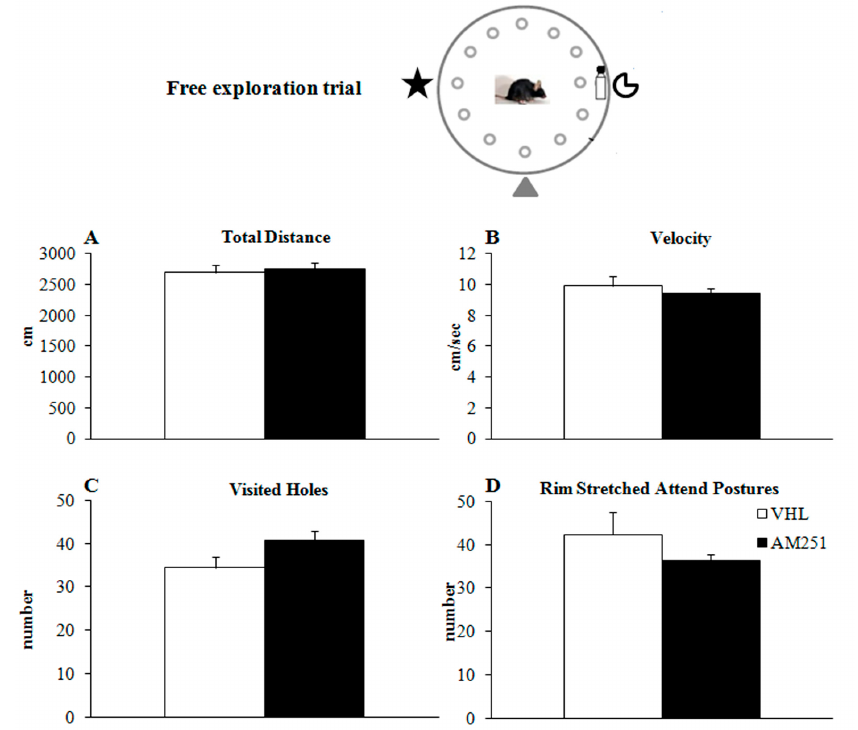
Figure 2. Behavior in the free exploration trial. Total distance ( A ), velocity ( B ), visited holes (the mouse put at least its nose in the hole) ( C ) and rim stretched attend postures (the mouse looked over the edge of the board) ( D ) exhibited by animals injected with AM251 or vehicle (VHL). The data presented as mean and standard errors were analyzed by one-way ANOVAs.